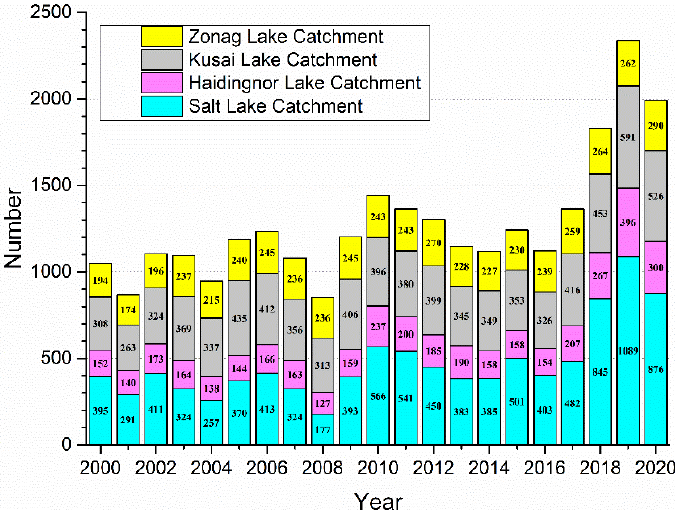
Figure 10. Number of small lakes and ponds in ZSLB during the period from 2000 to